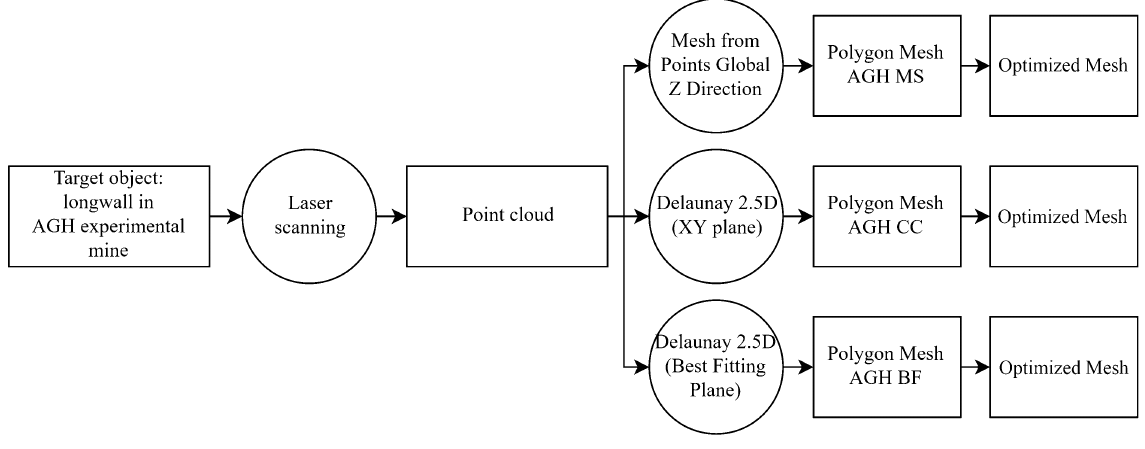
Fig. 5 The AGH experimental mine case study